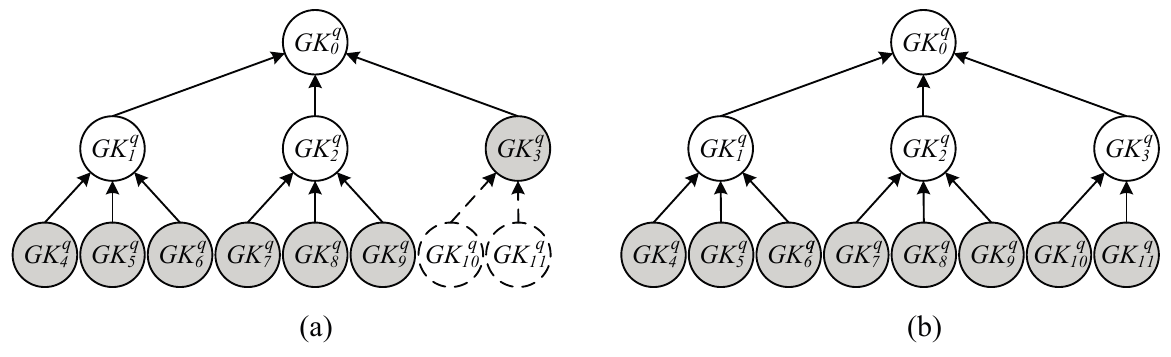
Figure 3. Examples showing group key selection in an incomplete group Tree: ( a ) the number of remaining tags (cid:1844)(cid:1827) ≤ reading capacity of (cid:1870) tags; ( b ) (cid:1844)(cid:1827) > (cid:1870) . Subsequently, the following two strategies were employed to distribute (cid:1844) keys to the reader with a reading capacity of r